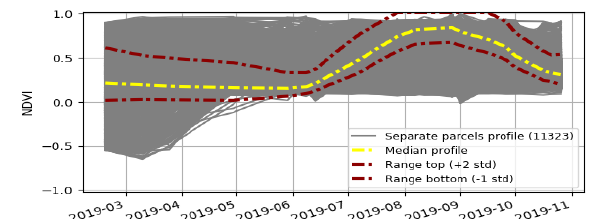
Figure 4. NDVI profiles of Cotton (CTN) parcels for the Sentinel-2 34SFH tile. The accepted parcels within standard deviation (std) range, above and below the median curve, were 4401 out of 11323. Figure 6. Median NDVI profiles for the rejected parcels of the L2 sub-classes of the Stone Fruit Trees (STN) L1 class from the 34TEL Sentinel-2